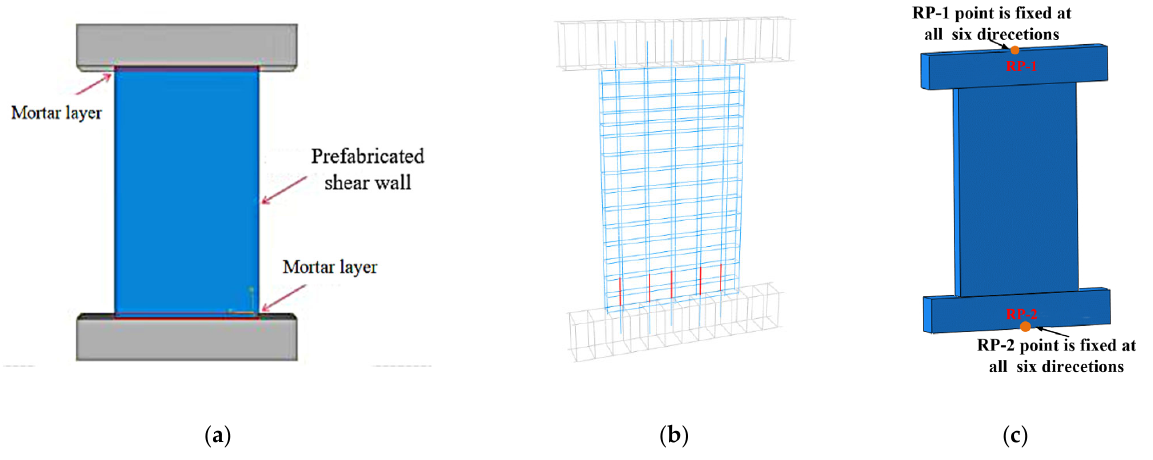
Figure 15. Finite element model diagram. ( a ) Shear wall. ( b ) Sleeves and reinforcement. ( c ) restraint fixed end.